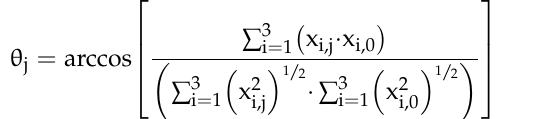
Table 1. Descriptions of variables.